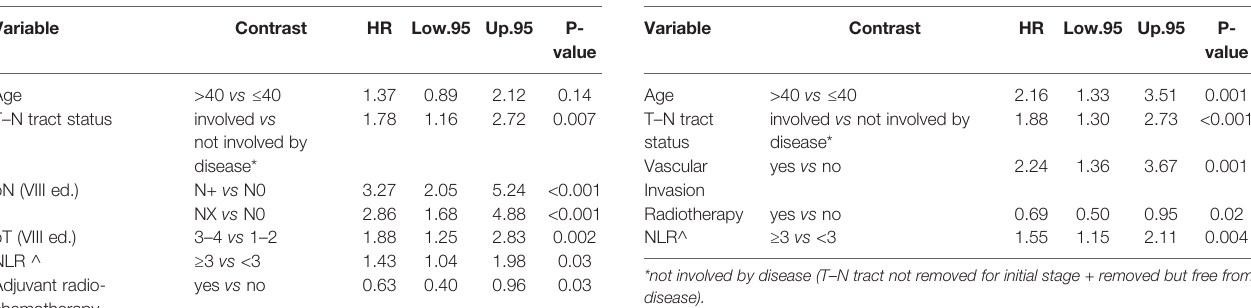
TABLE 6 | Multivariate Cox model for OS, stages III – IV.